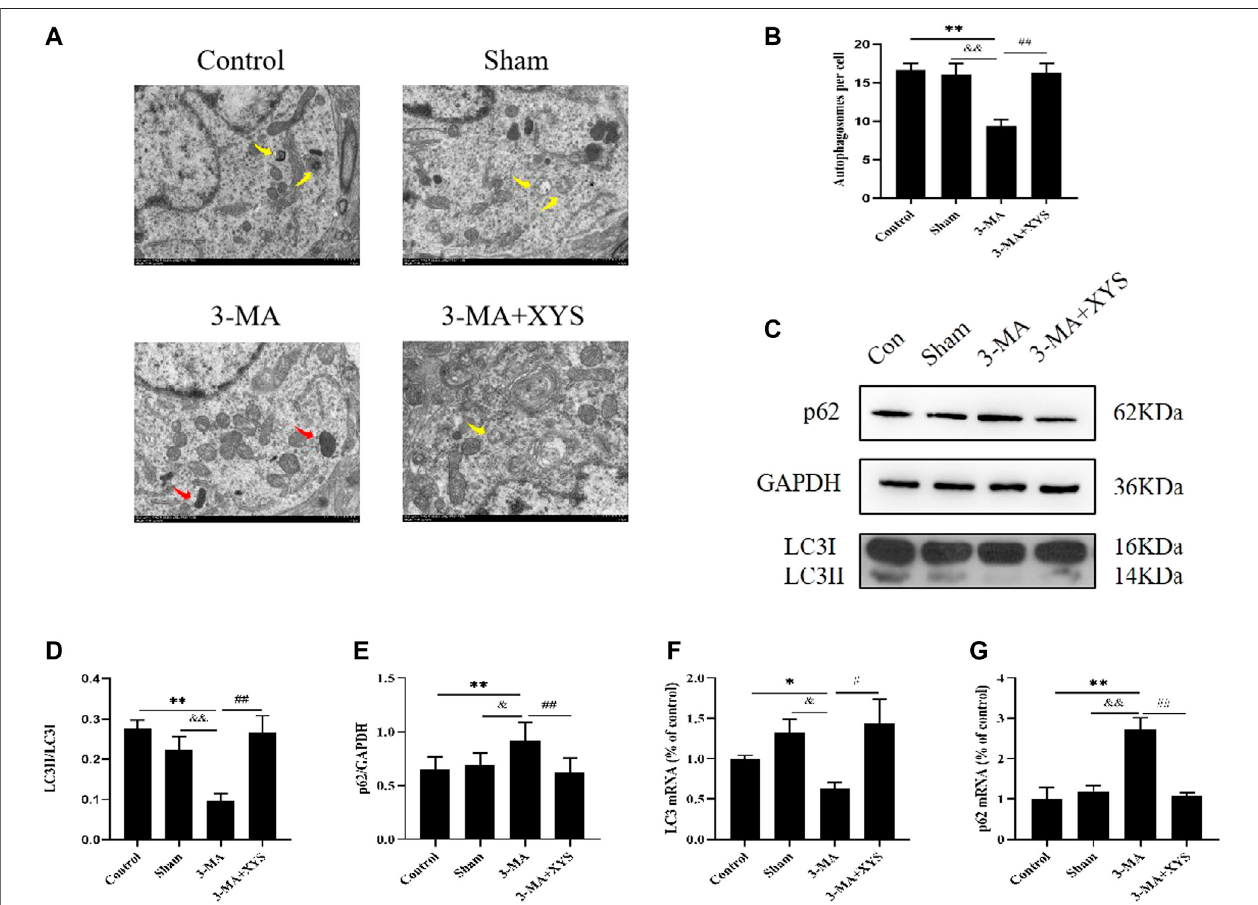
FIGURE 8 | Xiaoyaosan Increased Autophagy Expression in Mice Injected with 3-MA. (A) Transmission electron microscope showed the situation of autophagosomes and mitochondria in the hypothalamus of the mice (scale bar = 1 µm). Mitochondria were disrupted in 3-MA group (the red arrow). Autophagosomes were observed in control, Sham and 3-MA + XYS group (yellow arrows). (B) The number of autophagosomes in the hypothalamus of the mice (F (3, 8) = 9.243, p = 0.0056,n =1). (C) Representativewesternblotting ofLC3 and p62expressions. (D) Quantitative analysisofprotein levels ofLC3(F(3, 16=7.689, p =0.0021, n= 5). (E) Quantitative analysis of protein levels of p62 (F (3, 16 = 4.772, p = 0.0146, n = 5). (F) The expression of LC3 mRNA (F (3, 12 = 3.998, p = 0.0346, n = 4). (G) The expression of p62 mRNA (F (3, 12 = 14.176, p = 0.0003, n = 4). The values represent the mean ± SEM. p p < 0.05 or pp p < 0.01 compared with the control group. & p < 0.05, & p < 0.01 compared with the 3-MA group. # p < 0.05, ## p < 0.01 compared with the 3-MA